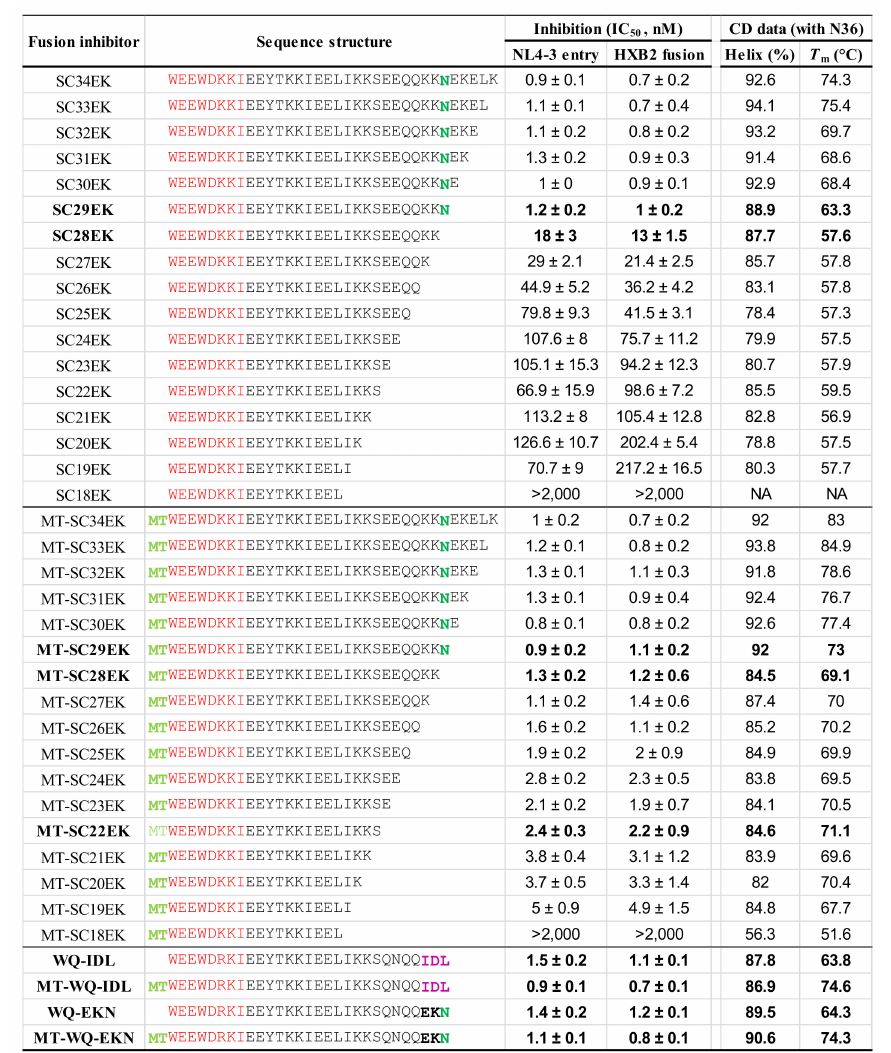
Figure 7. Structural and functional characterization for the functionalities of Asn-145 in helical peptide inhibitors. The inhibitory activities of electrostatically constrained inhibitors on HIV-1 NL4-3(D36G) pseudovirus entry and HIV-1 HXB2 Env-mediated cell–cell fusion were determined, with the experiments performed in triplicate and repeated three times, and data are expressed as means ± SD. The α -helicity and binding thermostability of diverse inhibitors were determined by circular dichroism (CD) spectroscopy, with the final concentration of each peptide at 10 µ M in PBS, and the experiments were repeated two times, and representative data are shown. The M-T hook residues, PBD, Asn-145, and IDL anchor are respectively marked in aqua, red, green, and magenta. NA, not